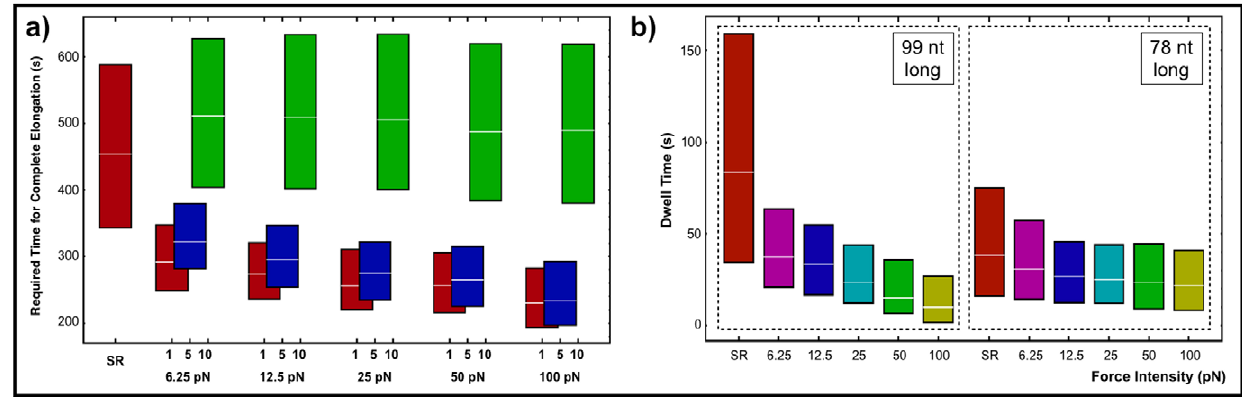
Figure 13. Force influence on multiple-round approach: a) Force influence on the required time for complete elongation. Red bars represent the first RNAP, blue bars represent the fifth RNAP and the green bar represents the tenth RNAP. b) Force influence on the dwell times for two representative nucleotide inclusions.